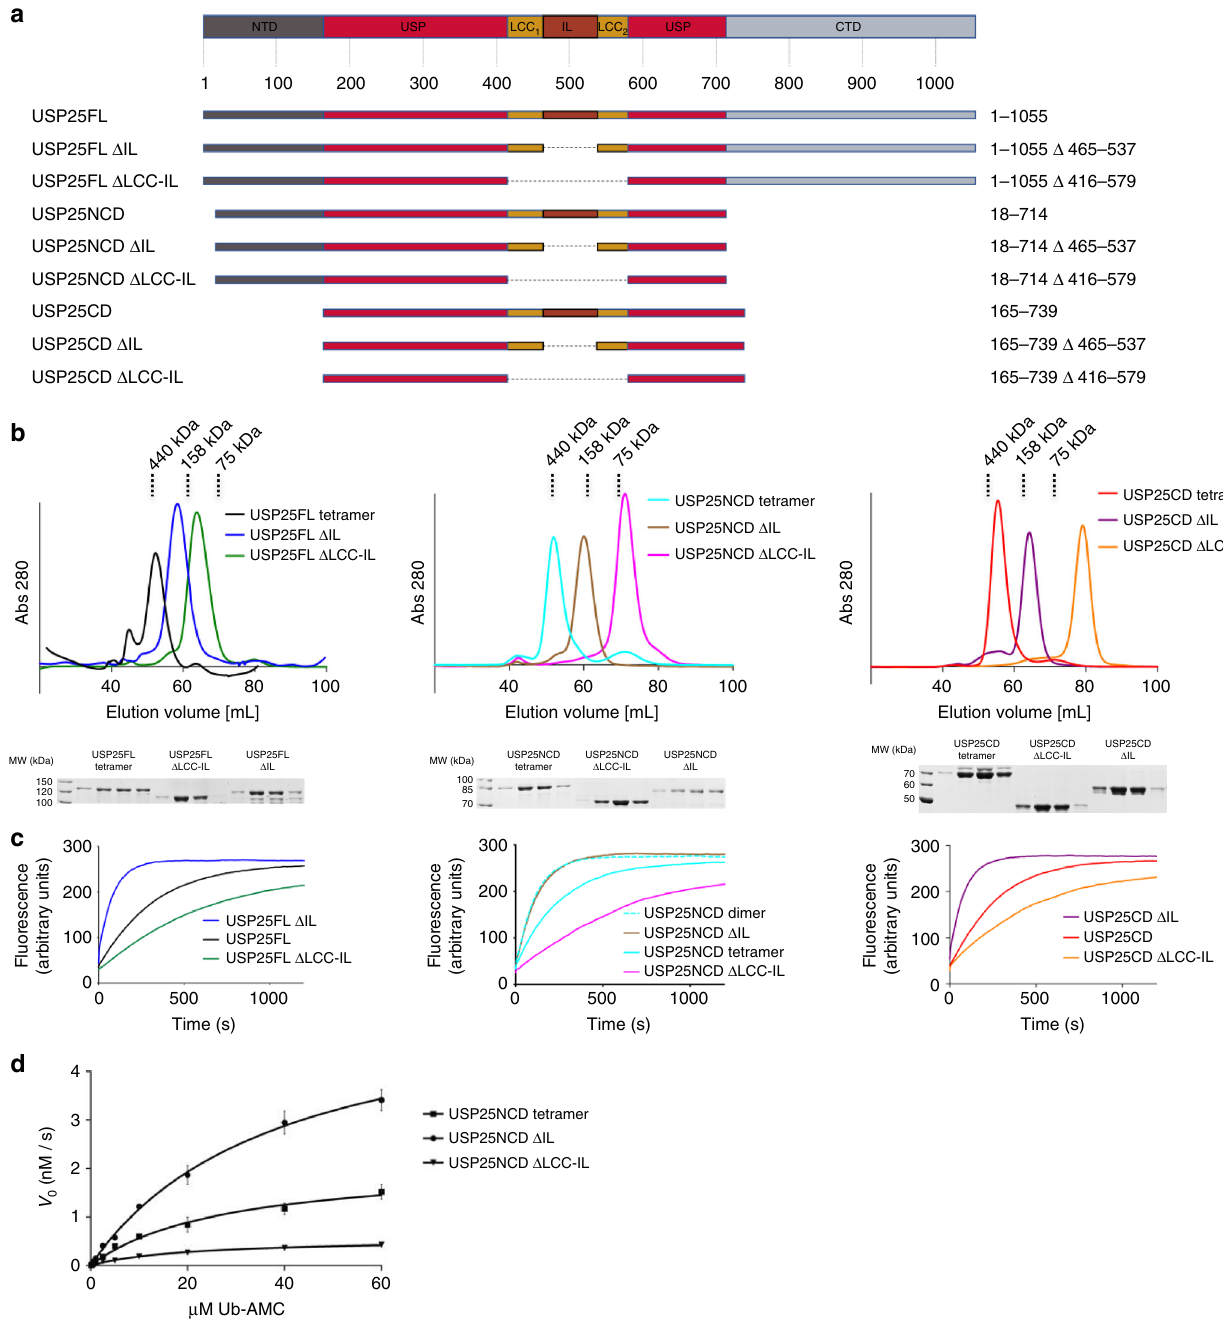
Fig. 5 Biochemical and kinetic analysis of the USP25 assemblies. a Cartoon representation of the different truncation constructs of USP25. Left columns indicate the names and the right columns the residue range for each construct. b Size-exclusion chromatography pro fi les of the different USP25 truncation constructs run under identical experimental conditions in Superdex 16 column. Below, SDS-PAGE of the fractions of the gel fi ltration peaks. c Deubiquitinating activity assays of the different elution fractions of the gel fi ltration chromatography using Ub-AMC as a substrate. Activity assays were run in triplicate. d Steady-state “ Michaelis – Menten ” kinetic plot of the indicated oligomer constructs of USP25, including the puri fi ed tetramer, the truncated dimer construct ( Δ IL) and the truncated monomer construct ( Δ LCC-IL). Error bars represent the standard error for two independent experiments